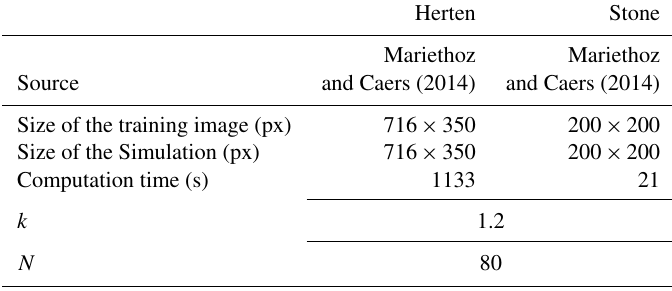
Table A3. Simulation parameters for Fig. A2. Times are specified for simulations without parallelization.